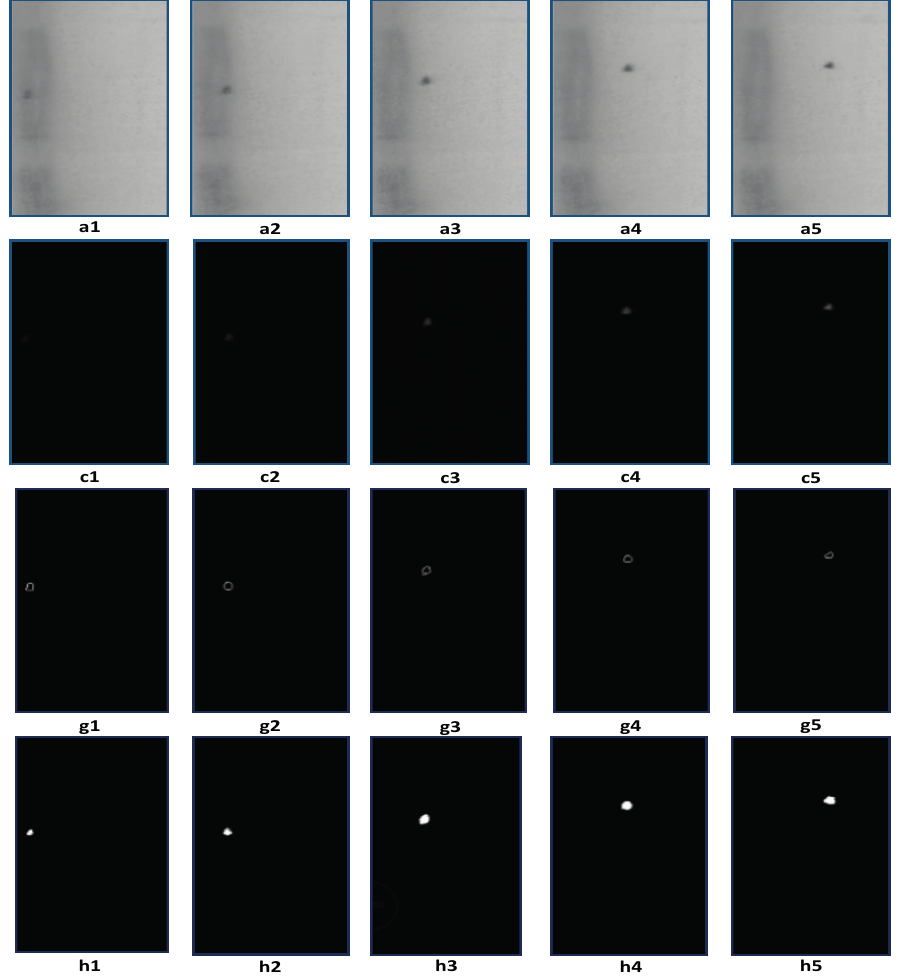
Figure 5. Foreign matter detection results comparison in the liquid region. ( a1–a5 ) Five sequential transfusion images; ( c1–c5 ) Detection results with inter-frame difference; ( g1–g5 ) Edge extraction results with the Canny operator after inter-frame difference; ( h1–h5 ) Detection results with the Gaussian background